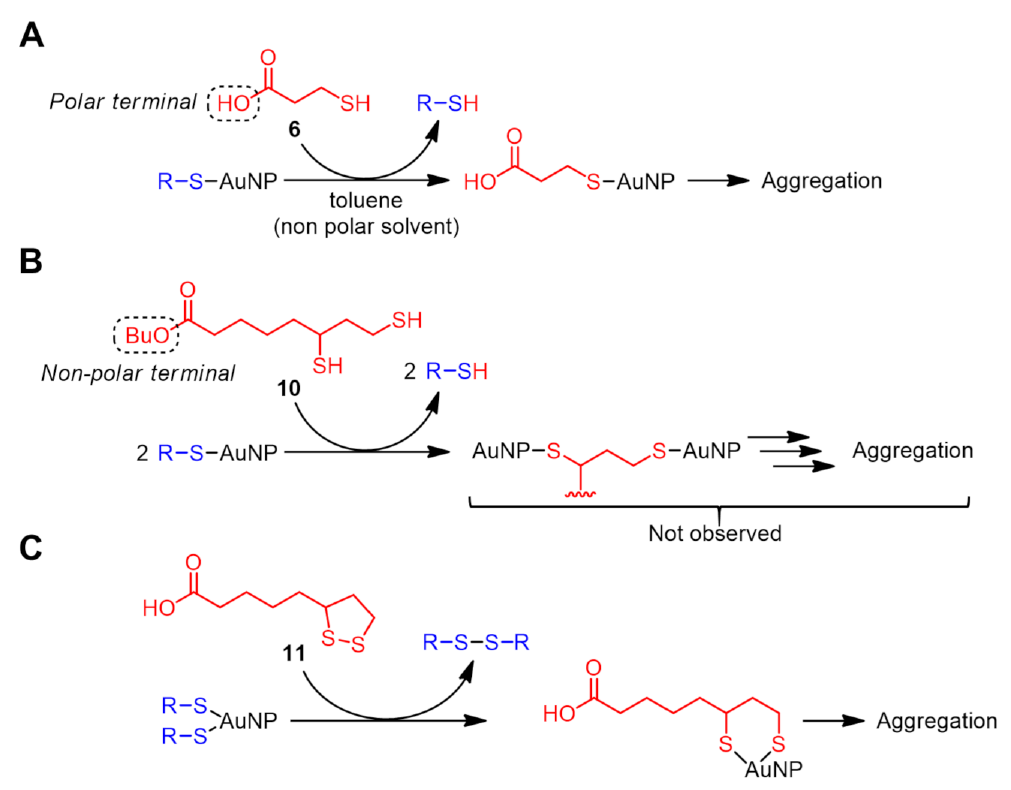
Figure 5. ( A ) Change in UV–vis absorption spectra of 1 @AuNP after ligand exchange reaction with sulfide compounds 3 – 12 in toluene (except 7 , which has poor solubility). Conditions: [ 1 @AuNP] = 0.20 µ mol/L, [ 3 – 12 ] = 1 mmol/L, room temperature, 10 h. ( B ) Absorbance at 450 nm where absorption of porphyrin is